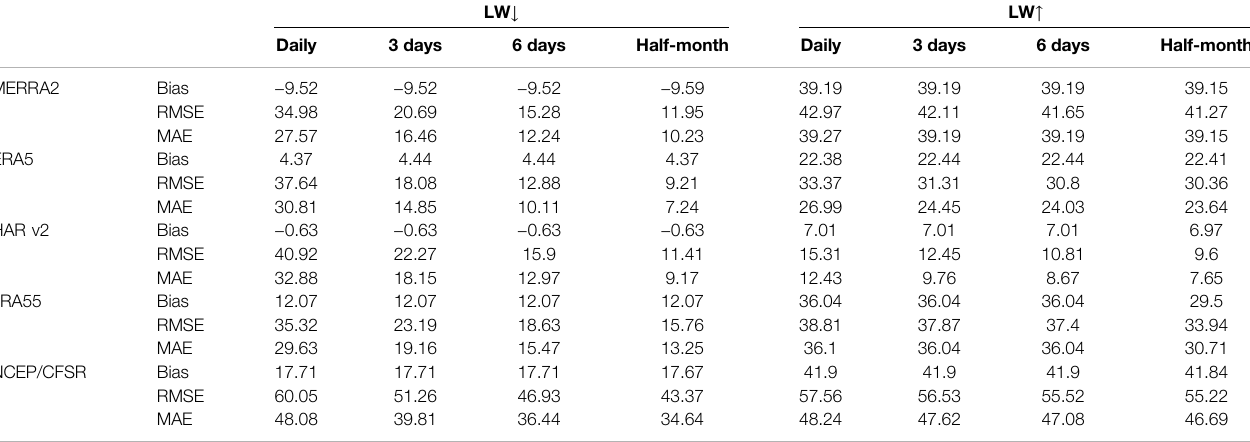
TABLE 6 | Evaluation of the day scales of longwave radiation from fi ve sets of reanalysis datasets. LW ↓ LW